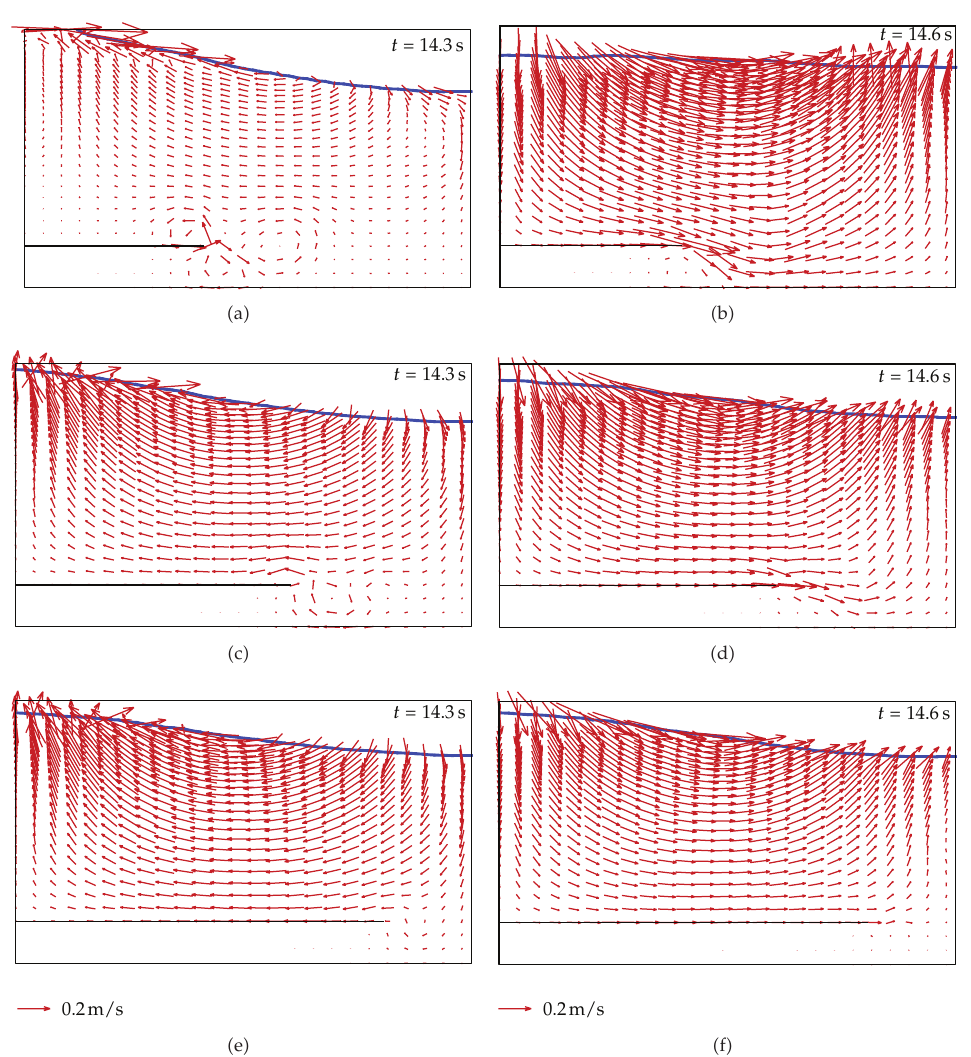
Figure 4: Velocity fields of liquid sloshing in a tank with di ff erent horizontal ba ffl e in